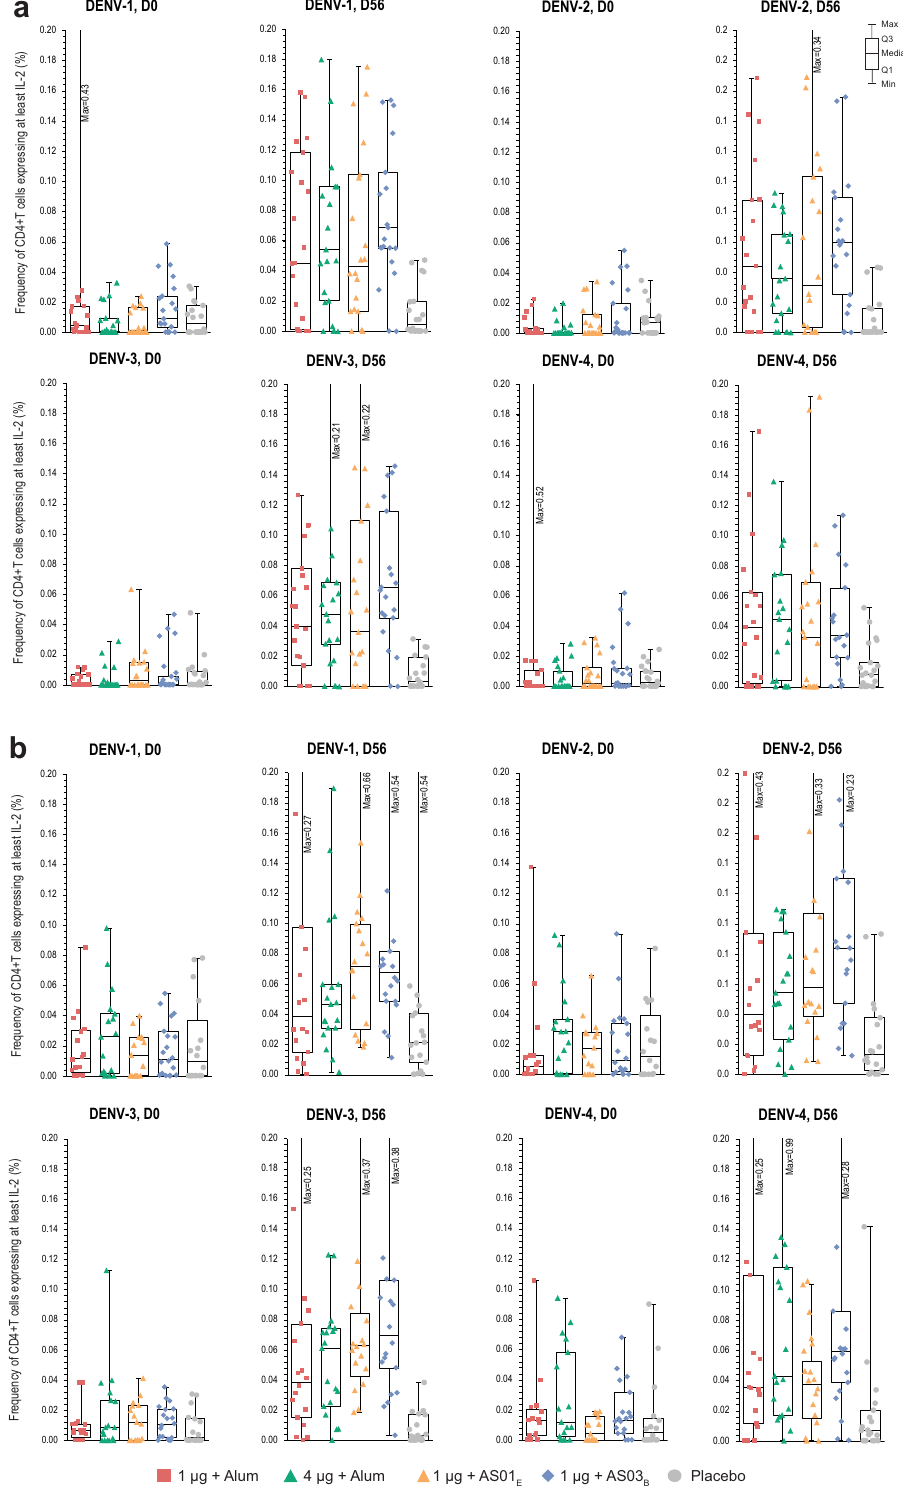
Fig. 3 Frequencies of CD4 + T cells speci fi c to dengue virus serotypes 1 – 4 expressing at least IL-2. T cells were quanti fi ed using the combined capsid/pre-membrane and envelope region peptide pools in the predominantly dengue-naive ( a ) and dengue-primed ( b ) populations (according-to-protocol cohort for cell-mediated immunogenicity at day 56), at day 0 (pre-vaccination) and day 56 following 2-dose DPIV administration. Individual values are plotted for each group. Error bars on the box plot represent the Min and Max values in each group. D, day; D0, pre-vaccination; D56, 28 days post-dose 2; DENV, dengue virus; DPIV, tetravalent dengue puri fi ed inactivated vaccine; Min/ Max, minimum/maximum observation; Q1, Q3, fi rst and third quartiles; ◊ , geometric mean frequency. For each serotype, the combined capsid/ pre-membrane and envelope region peptide pools ((C + M) + E pool)-speci fi c frequency was derived by adding the (C + M) pool speci fi c frequency and the E pool speci fi c frequency. Note: Data were not